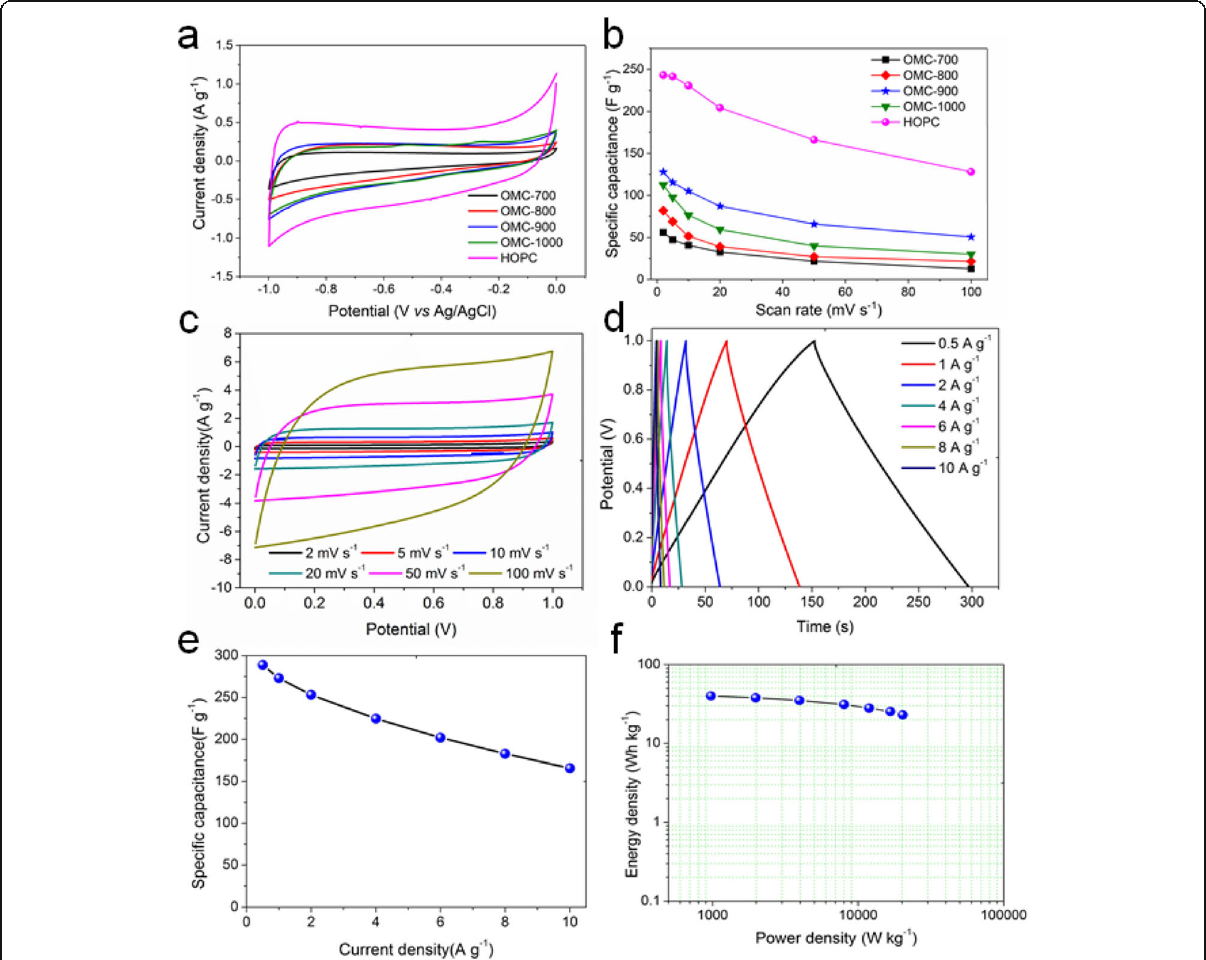
Fig. 4 a Cyclic voltammetry (CV) profiles of the OMC-700, OMC-800, OMC-900, OMC-1000, and HOPC electrodes at a scan rate of 2 mV s − 1 using the three-electrode configuration and b corresponding specific capacitance. c CV profiles of the HOPC electrode in the symmetric two-electrode supercapacitor at scan rates varying from 2 mV s − 1 to 100 mV s − 1 in 6 M KOH aqueous electrolyte. d Charge-discharge curves at different current density from 0.5 A g − 1 to 10 A g − 1 . e Specific capacitance calculated from the discharge curves from the charge-discharge testing. f Ragone plots showing the energy density as a function of power t . Figure S13b shows the plots of C as a function of image frequency. The character frequency of the OMC-700, OMC-800, OMC-900, OMC-1000, and HOPC sample is 0.01 Hz, 0.1 Hz, 0.01 Hz, 0.01 Hz, and 0.5 Hz, and the corresponding time constant is 100 s, 10 s, 100 s, 100 s, and 2 s. The HOPC sample shows the highest character frequency and the lowest time constant, indicating the fastest response to power output.